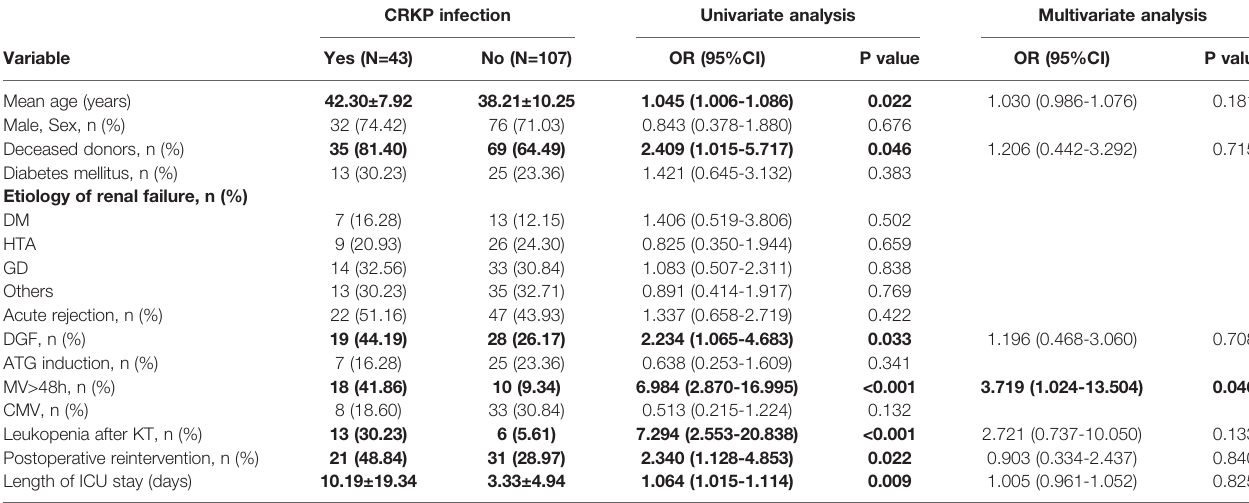
TABLE 2 | Univariate and multivariate analysis of the risk of carbapenem-resistant Klebsiella pneumoniae infection in 150 kidney transplant recipients. CRKP infection Univariate analysis Multivariate analysis